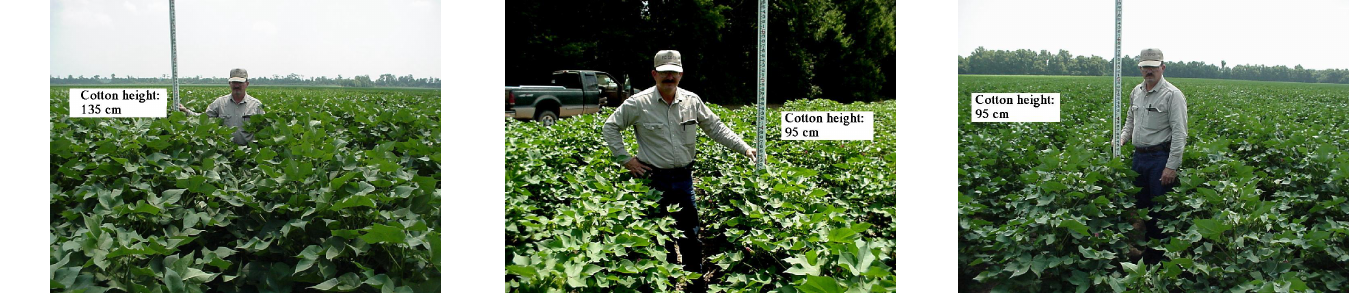
FIGURE 18. (A) Cotton growing in sandy soil that received a single rate of 50 kg of N/ha; (B) a sandy soil area of the adjacent field that received 0 N/ha; (C) a clayey soil area in the same field that received 100 kg of